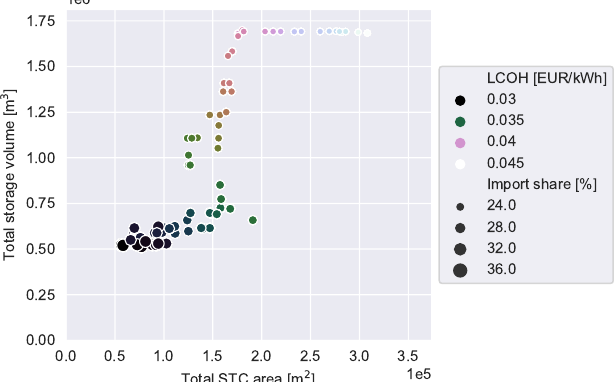
Figure 8. Distribution of total STC area compared to the total storage volume. The scatter points are coloured according to the LCOH, with darker values representing a lower LCOH than the lighter values. The larger the dot, the larger the import share (and thus the larger the grid dependence of the network). Note that the axes are limited by the minimum and maximum allowed design